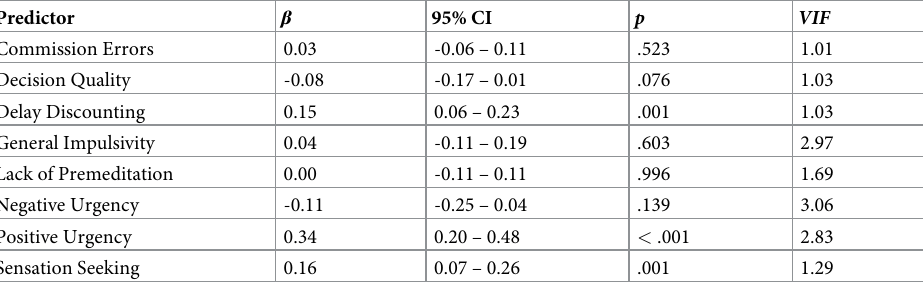
Table 2. Regression Model 1 results predicting the interpersonal facet.